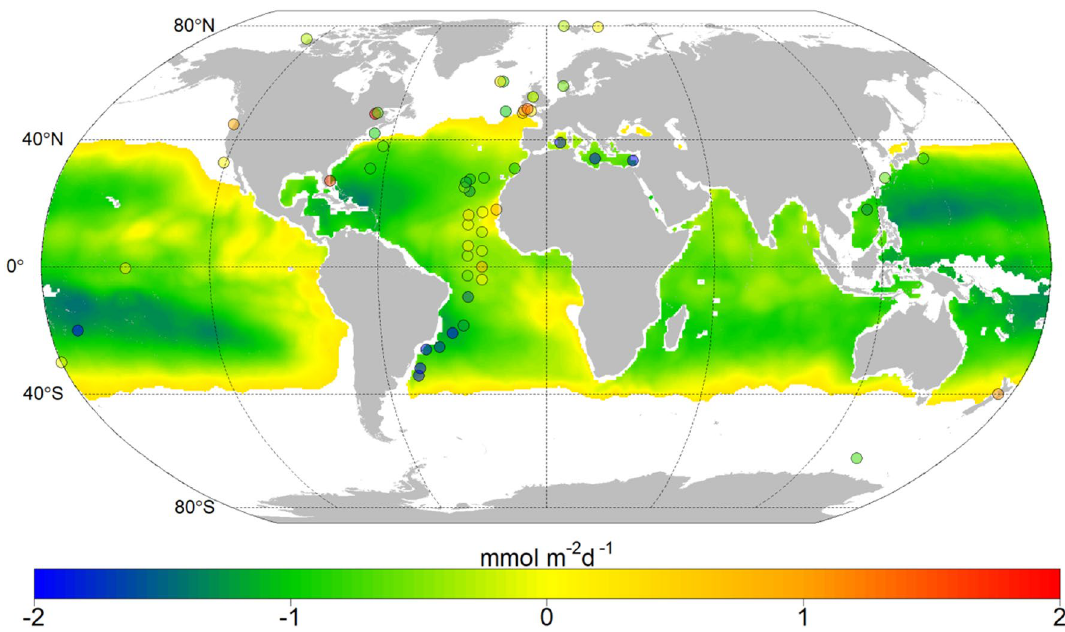
Figure 5. Global distribution of the decimal logarithm of nitrate diffusive fluxes derived by using the GM model specified in Table 3. The colored dots represent nitrate diffusive fluxes previously reported in the literature and described in Table 5. The white color indicates those regions where data were outside of the range covered by the dataset used to build the prediction model. Figure was generated by using RStudio (https:// www. rstud io. com) (Version